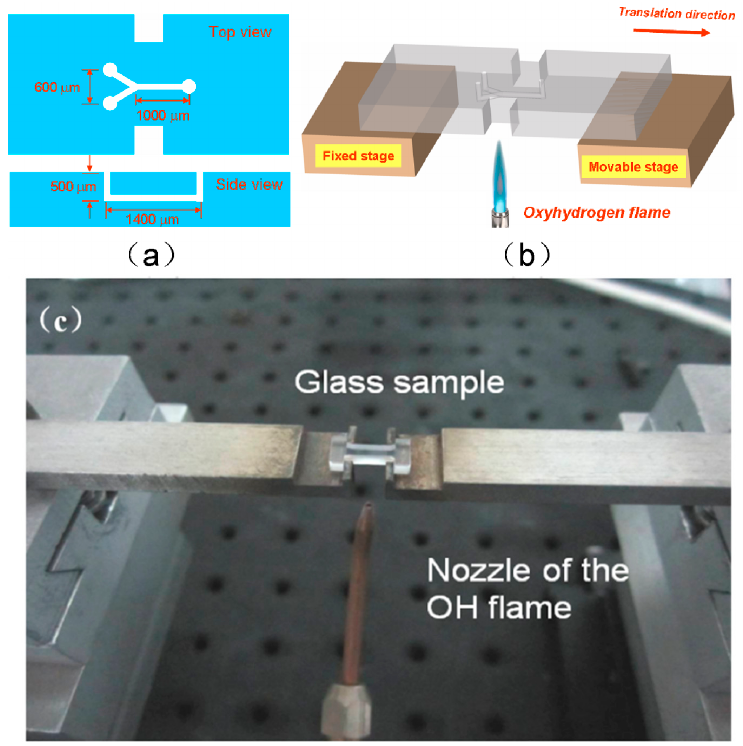
Figure 3. Schematics of ( a ) 3-D microfluidic channel and ( b ) the glass drawing setup; ( c ) picture of the glass drawing setup.